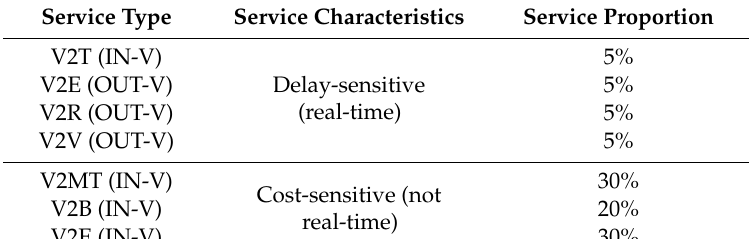
Table 3. Multi-service splitting parameters (2).